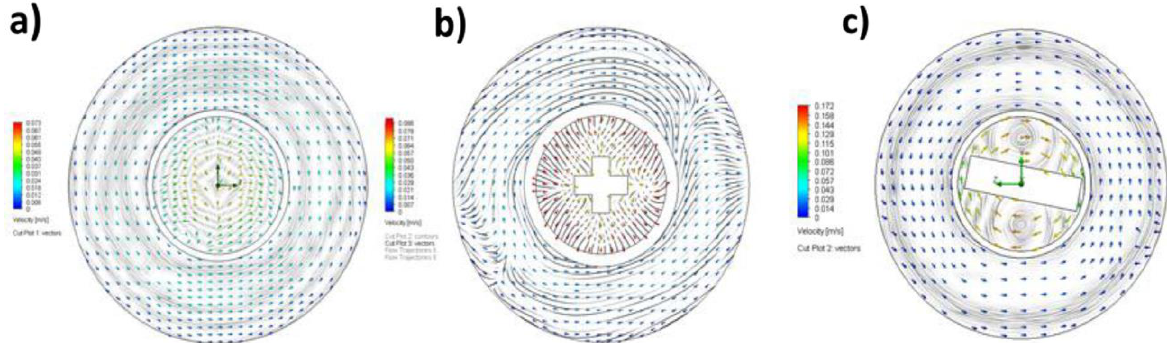
Figure 5: The turbulence intensity inside the different setups (a) plain tube (b) X -shape tape (c) stainless steel variable [13].